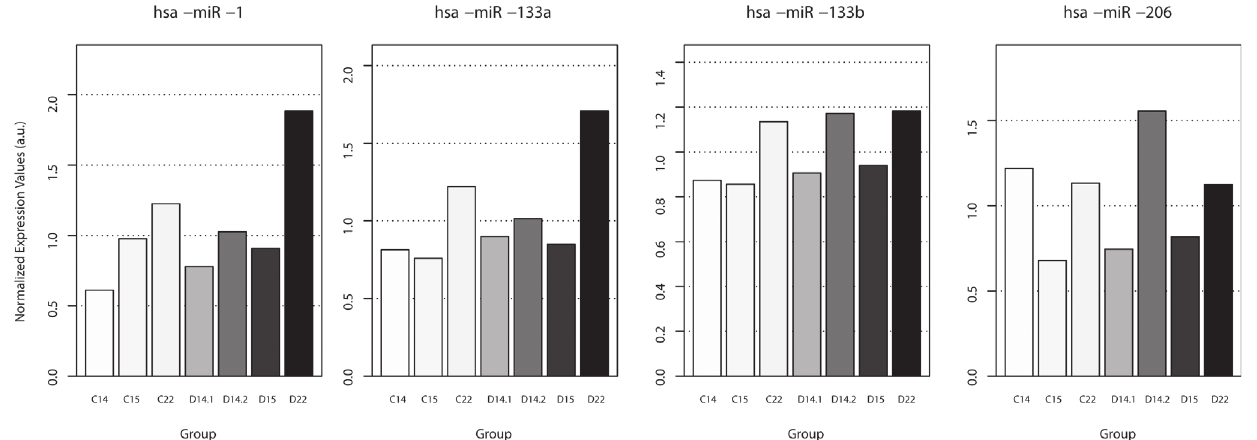
Figure 2. Expression of myomiR in fetal muscle biopsies from FSHD1 are similar to fetal control muscle biopsies. Age-matched pair-wise comparison of myomiRs expression in FSHD1 (D) and healthy control biopsies (C) at 14, 15 and 22 weeks of